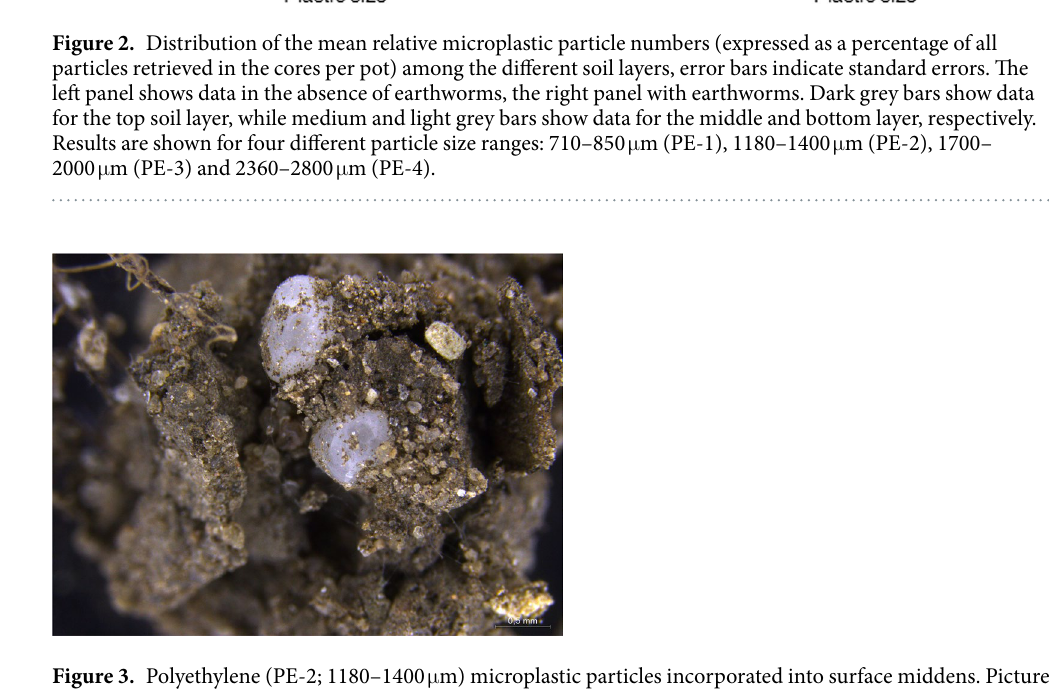
Figure 3. Polyethylene (PE-2; 1180–1400 μ m) microplastic particles incorporated into surface middens. Picture taken during the harvest of the